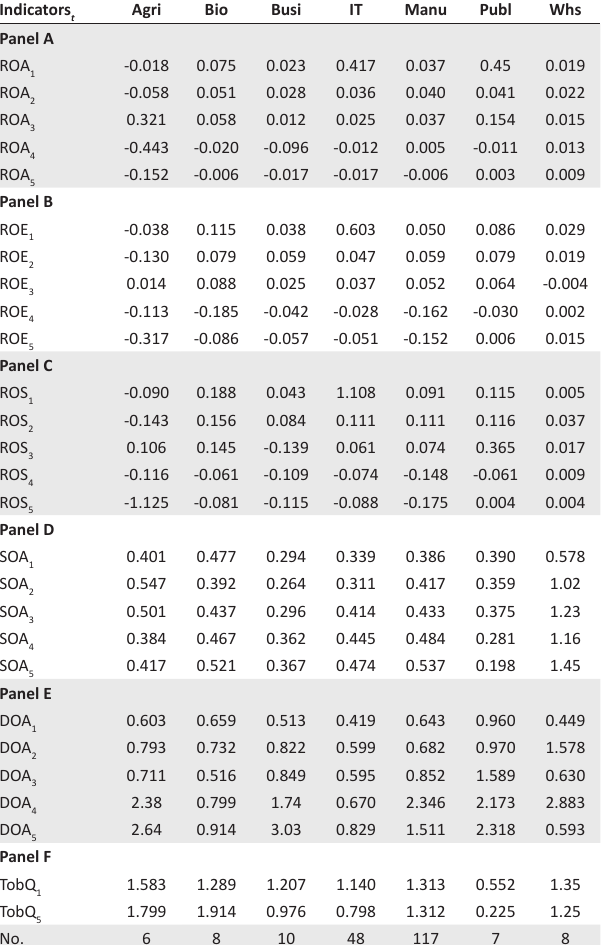
TABLE 6: Sustainability test of the IPO firms over 5 years after going public by industrial sectors. Indicators Agri t